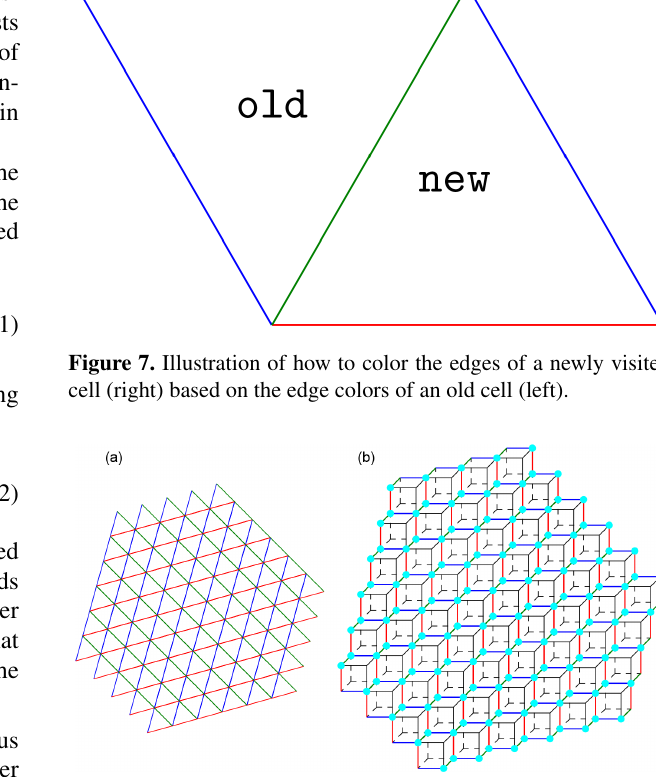
Figure 8. Illustration of compute_cubulation . The triangular grid is shown in (a) and the corresponding cubical grid in (b) . In (b) , cyan vertices correspond to triangle centers in (a) , and analogously for colored edges. Vertices with no colors in (b) do not correspond to triangle